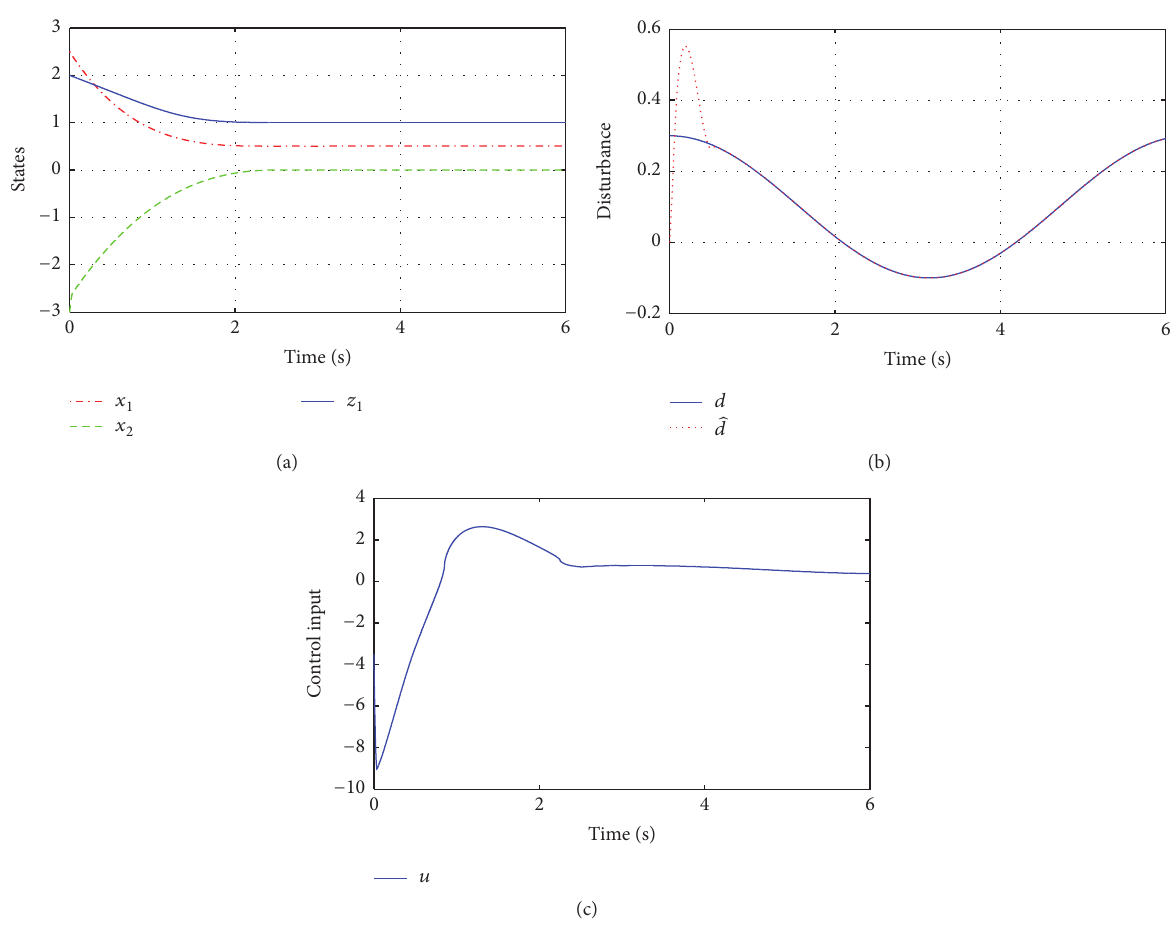
Figure 5: Response curves of the closed-loop systems